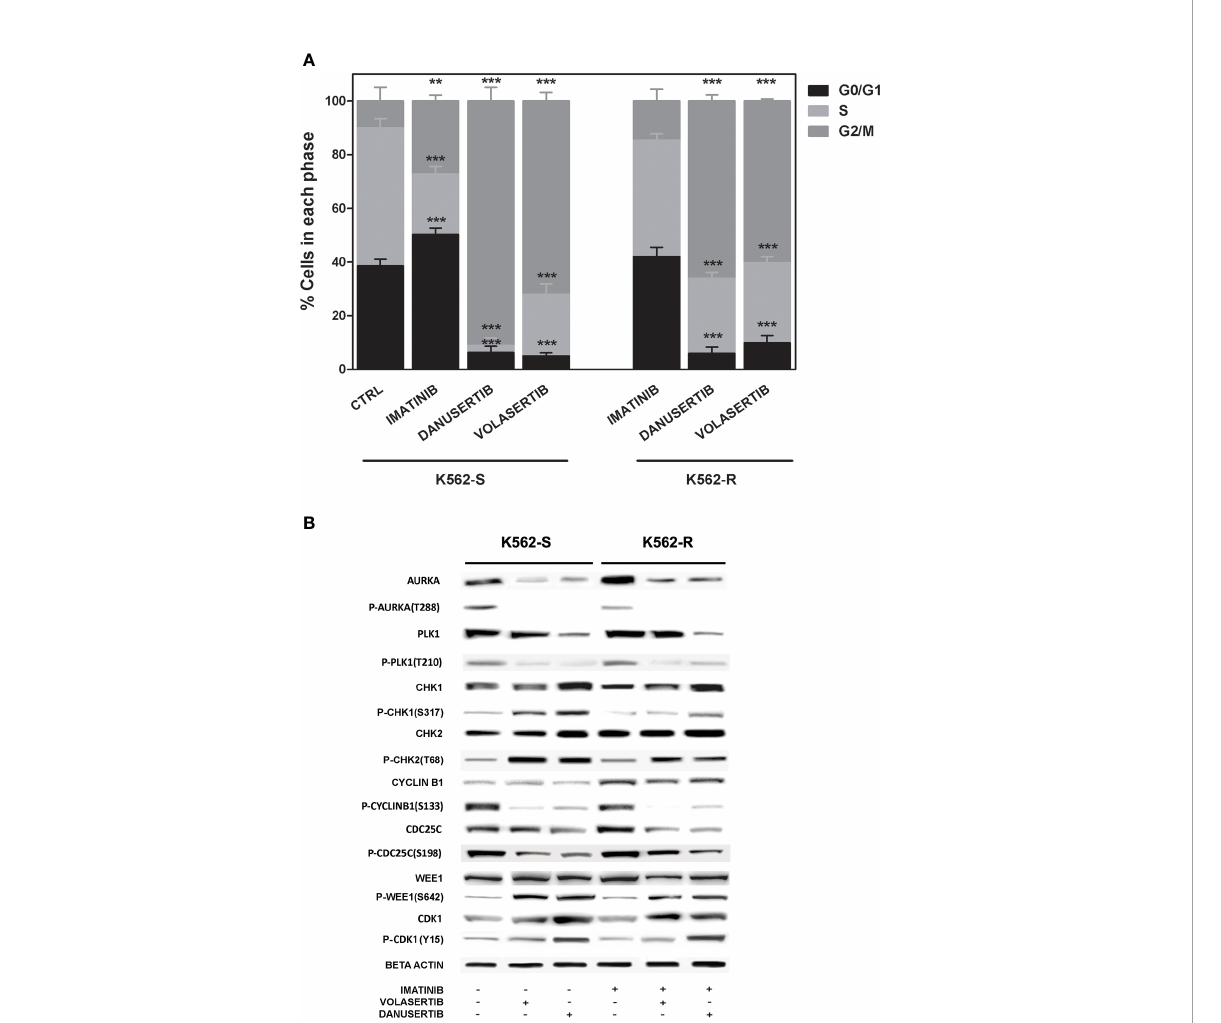
FIGURE 2 Effects of Aurora kinase A and PLK1 inhibition on cell cycle. (A) Flow cytometry analysis of cell cycle. K562S and K562R cells were treated with 1 µM of imatinib, danusertib or volasertib for 24 hours. Asterisks indicate a signi fi cant difference between control (for K562S) and imatinib-treated (for K562R) cells and between treatments with danusertib and volasertib. (B) Western blotting analysis of cell cycle-related proteins in K562S and K562R cells treated with 1 µM of imatinib, danusertib and volasertib for 24 hours. Beta-Actin was used as loading control. Densitometric analyses of each gel were performed by using a dedicated software (ImageJ). Results are detailed in the Supplementary section. All Western blotting assays were performed starting from lysates obtained by three independent drug treatments for each sample.. **p< 0.01, ***p< 0.001, p ≤